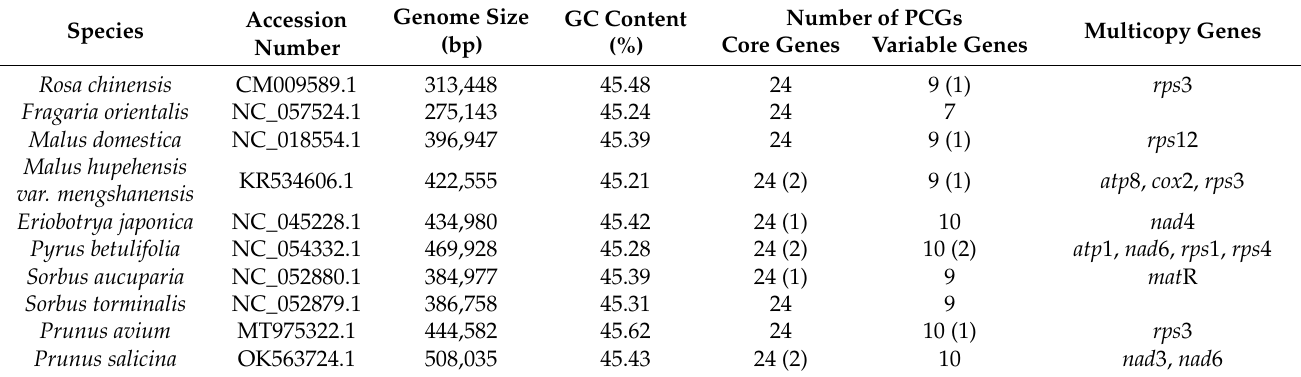
Table 2. Comparison of mitogenomes among 10 Rosaceae